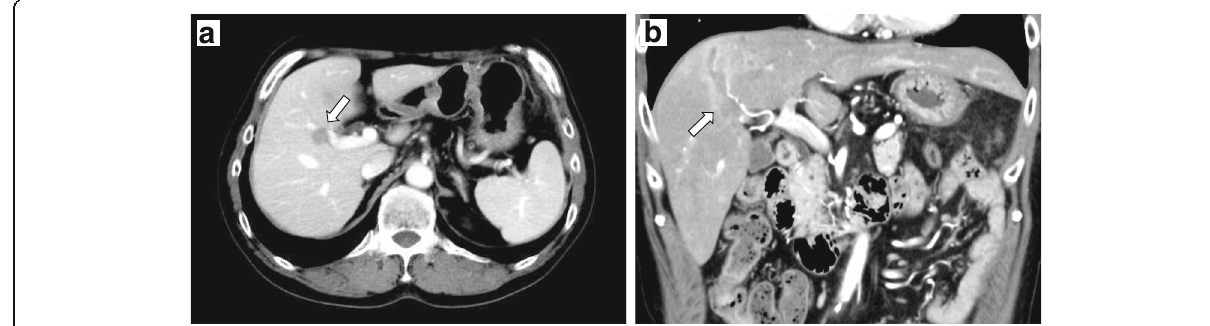
Fig. 2 Enhanced abdominal computed tomography. a Imaging showed portal vein thrombosis in P8 (white arrow). b The tumor thrombosis was extended from P8 to the root of P5, and slight inflammation surrounding the portal vein was detected (white arrow)